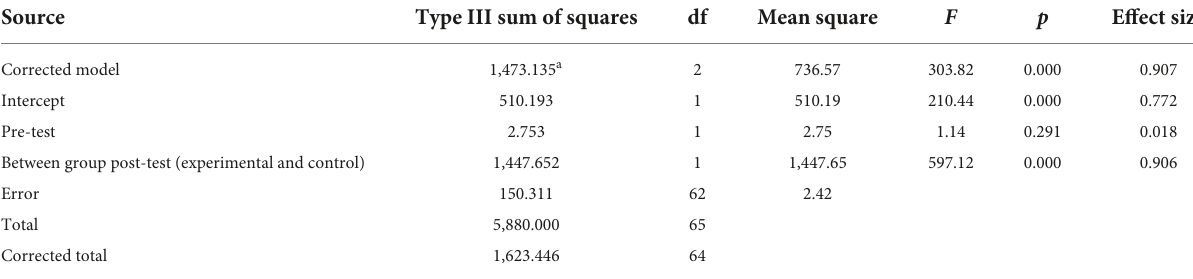
TABLE 5 Analysis of covariance (ANCOVA) result on students’ ability to edit composition writing after exposure to concept mapping instruction.